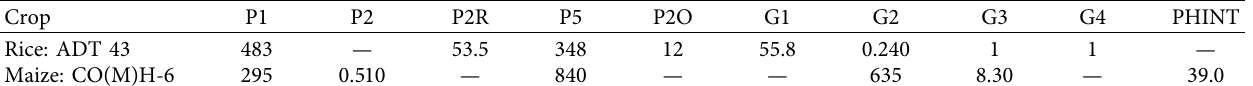
Table 2: Genetic coefcients of rice and maize